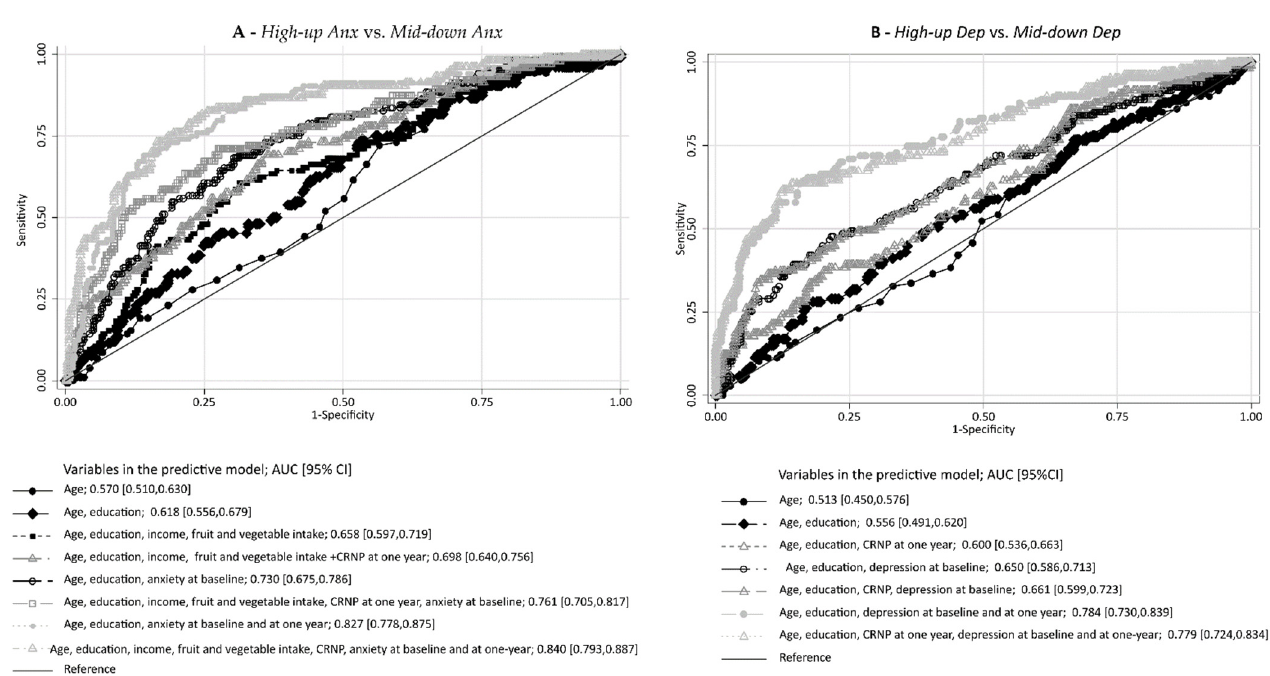
Figure 2. Predictive models for High-up Anx vs. Mid-down Anx trajectory ( A ) and for High-up Dep vs. Mid-down Dep trajectory ( B ).